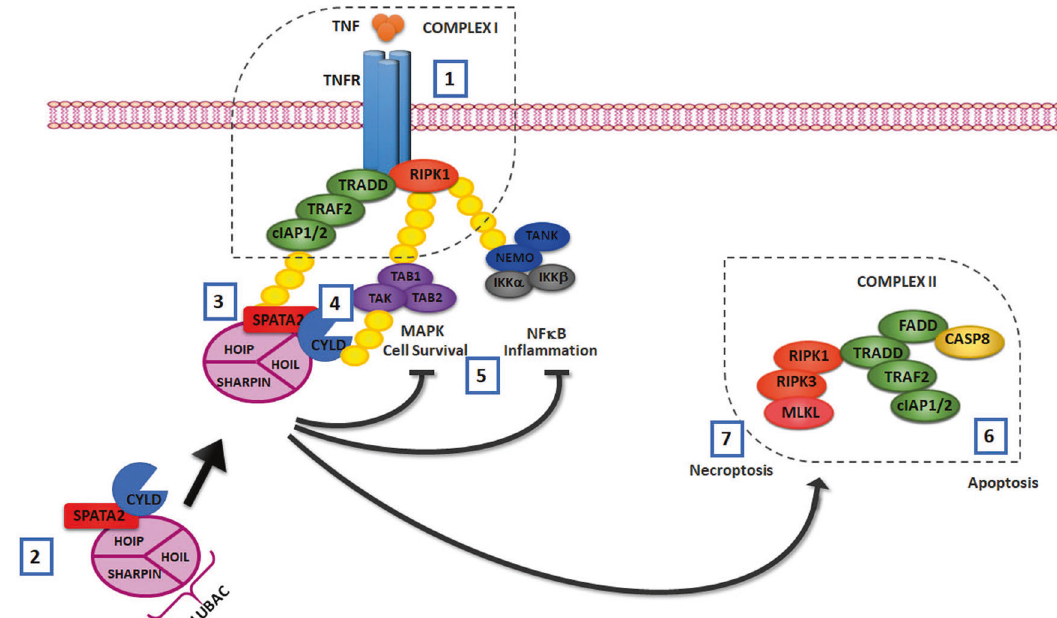
Fig. 1 Role of SPATA2 at the level of TNF-RSC. After stimulation by TNF α (1), the CYLD/SPATA2/LUBAC complex (just pre-existing in the cytosol (2) is recruited into the receptor complex I through the interaction of LUBAC with the ubiquitin chains present in the complex (3). At the same time, the direct interaction of SPATA2 with CYLD results in an increase in the enzymatic activity of the latter which mediates the de- ubiquitylation (4) of some complex components such as RIPK1 – thus playing a fundamental role in attenuating the signaling pathway triggered by TNF α . Therefore, activated CYLD attenuates NF-kB pro-in fl ammatory signaling and MAPK pro-cell-survival response (5). Alternatively, a second complex (named complex 2) can form by recruiting, among other factors, RIPK1, FADD, and caspase-8 – thus resulting in the induction of apoptotic cell death (6). If caspase-8 is inhibited, assembly following TNF stimulation promotes an alternative complex 2 with MLKL leading to necroptotic cell death